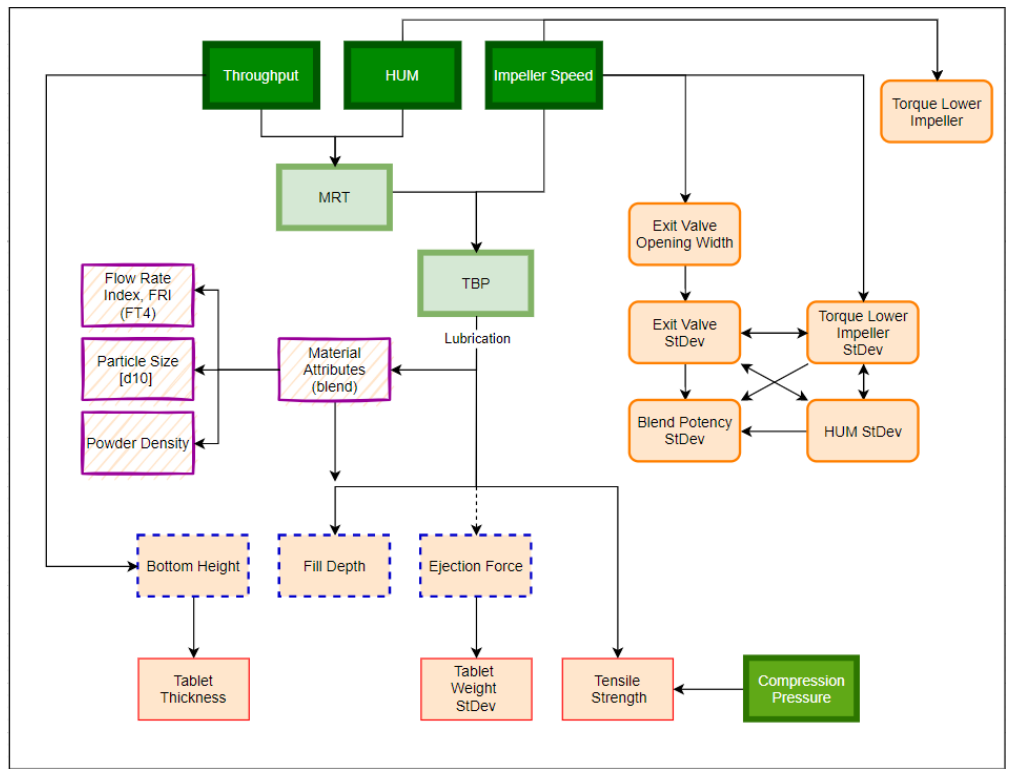
Figure 9. Qualitative overview of process parameter connections and correlations. Input factors are marked in dark green (thick borders), confounding input parameters are marked in light green and the considered response parameters are shown in light orange. The color/shape of the borders classifies the responses into mixing parameters (orange line, rounded corners), material attributes of the blend (purple, striped background), tableting parameters (blue, dotted borders) and tablet properties (red, thin borders). Compression pressure (green) is considered an independent input factor of the tablet press.